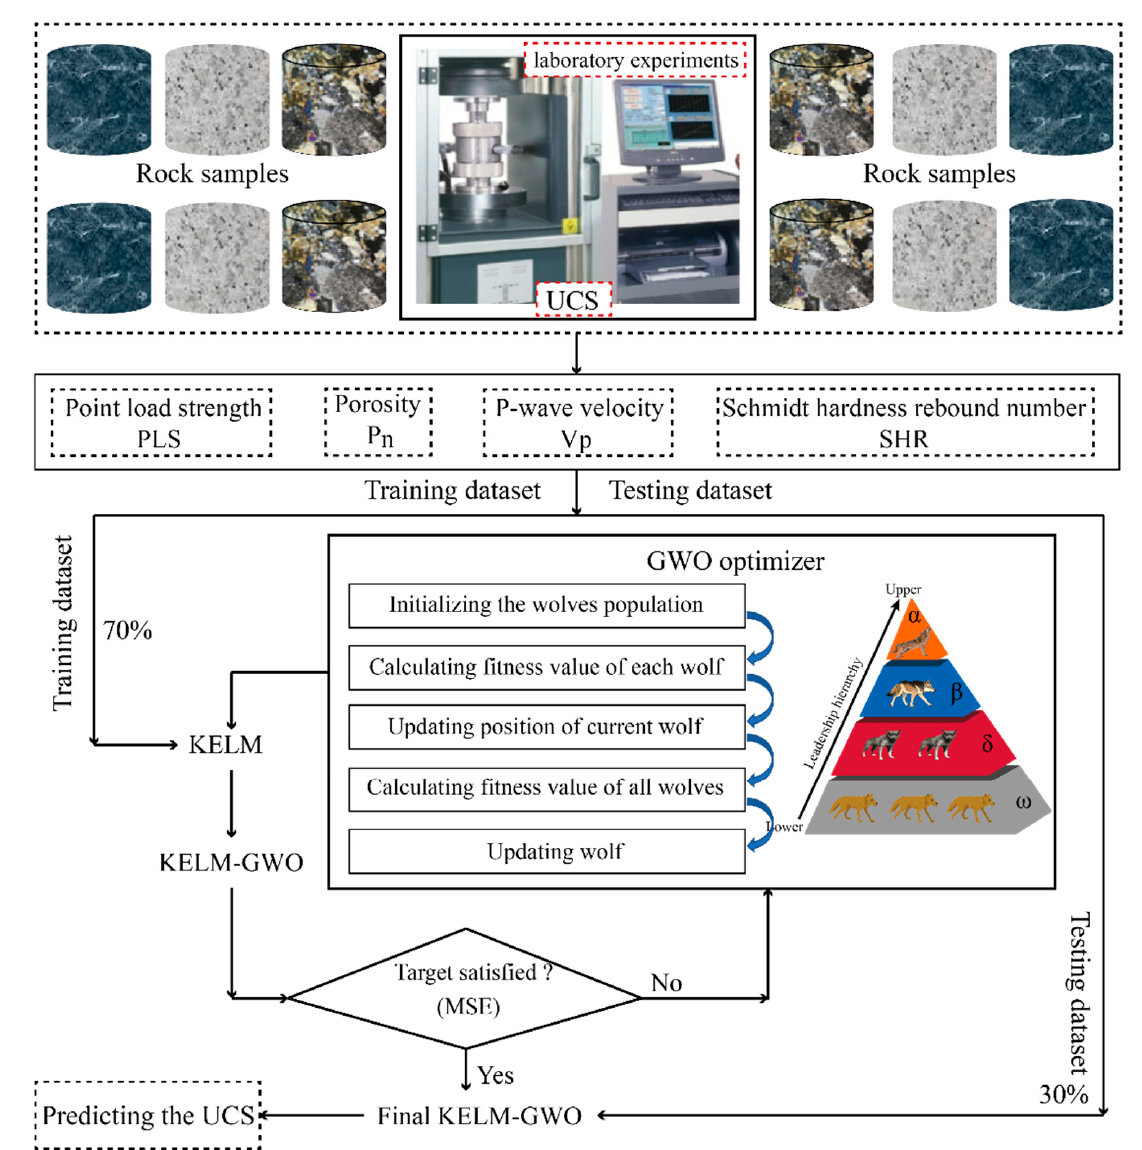
Figure 2. Flowchart of developing the KELM-GWO model for UCS prediction.